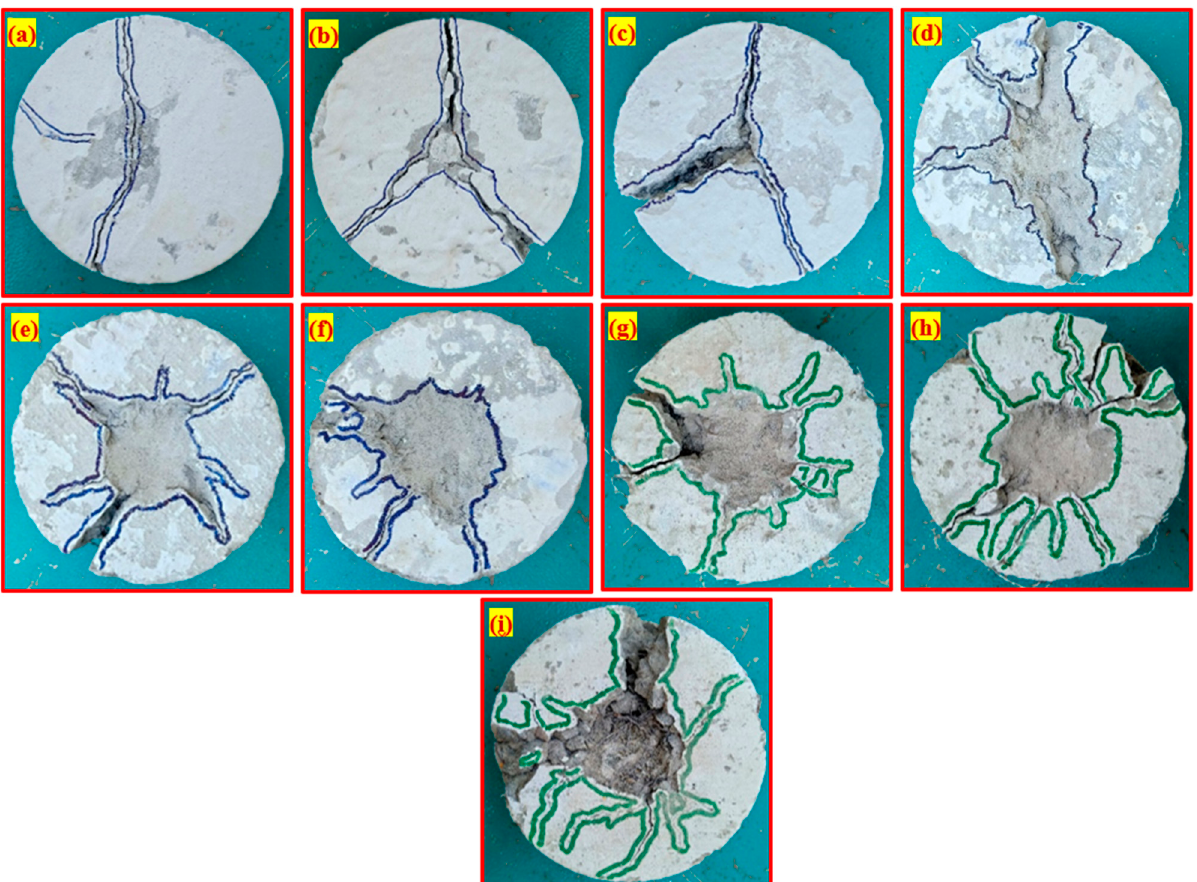
Figure 17. Failure modes of PAFC ( a ) NC, ( b ) NC-C1, ( c ) NC-C2, ( d ) P-PF, ( e ) P-PF-C1, ( f ) P-PF-C2, ( g ) P-SF, ( h ) P-SF-C1 and ( i ) P-SF-C2.